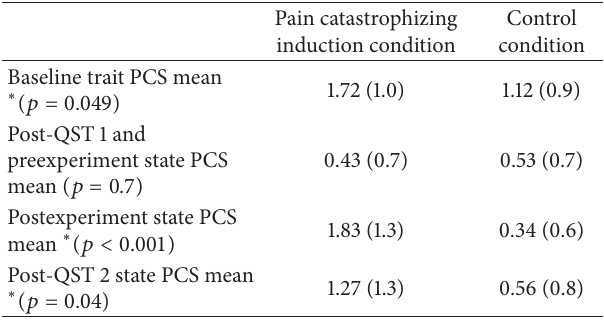
Table 1: Trait and state PCS scores.